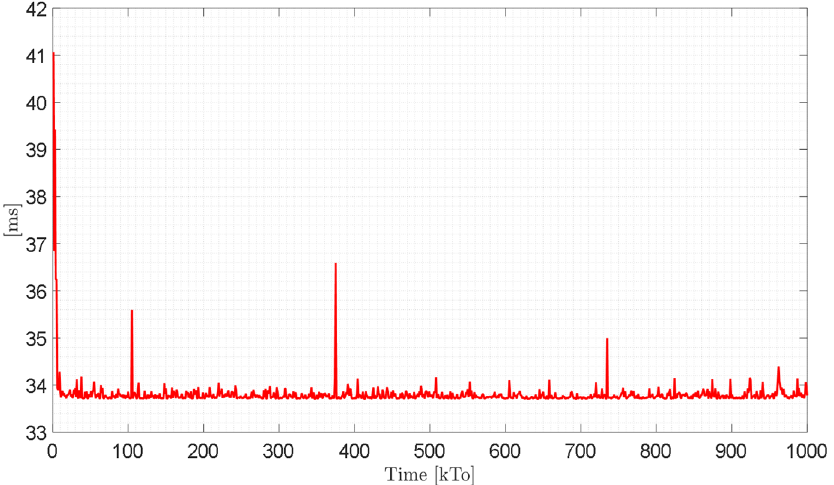
Figure 29. Algorithm execution time during Hardware in the Loop technique.